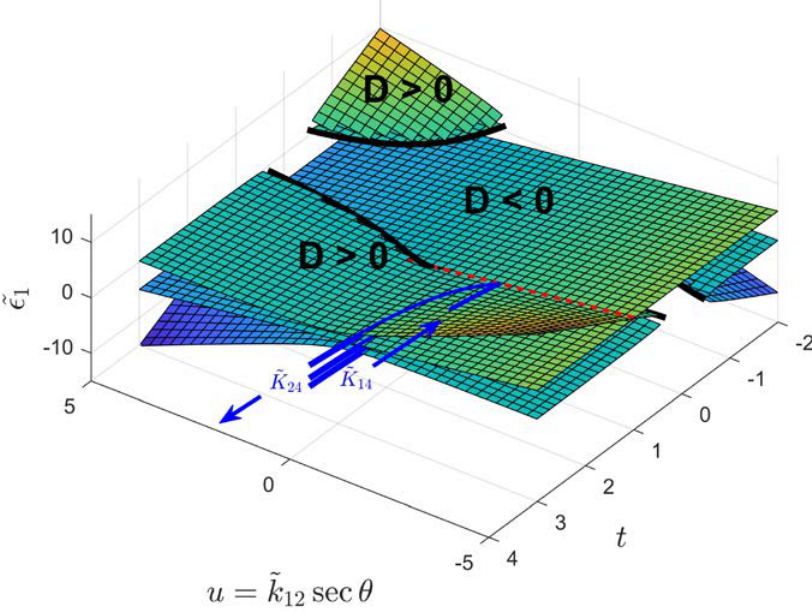
0 r q =  surfaces. D denotes the = 0 surfaces. D denotes the 2eff 2eff √ ±√ 1 − t and (cid:101) ε 1 = 1 − t ( t ≤ 1 ) (from